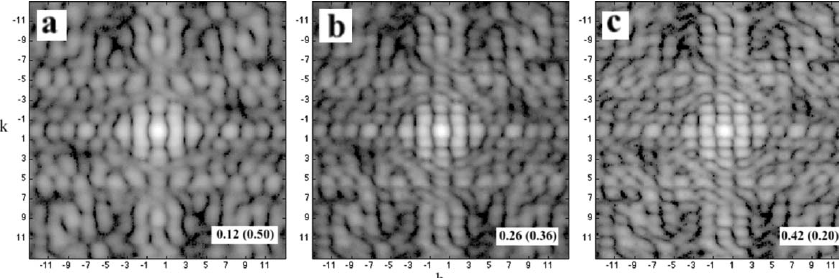
Figure 10 Crystal shape variations do not reduce the recovered molecular transform qualities. The fraction of boundary that is covered by partial unit cell is the determining factor for the recovered unit-cell patterns. The fractions are 0.2, 0.5, 0.8 for ( a ), ( b ), ( c ), correspondingly. The numbers shown in the lower right corners are the R factors compared with the theoretical unit-cell transform, relative to the default unit cell; and the values in parentheses are the R factors compared with the alternative unit-cell transform (see Fig. 2 h ).